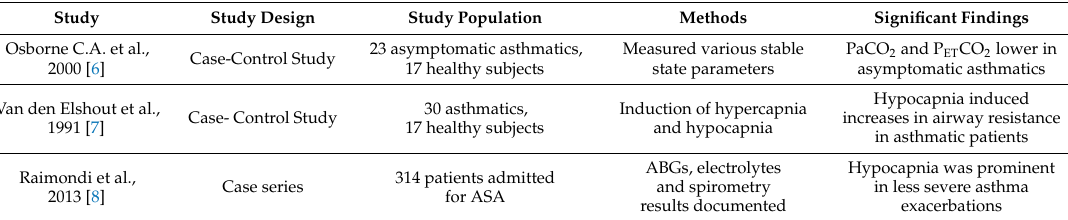
Table 1. Respiratory